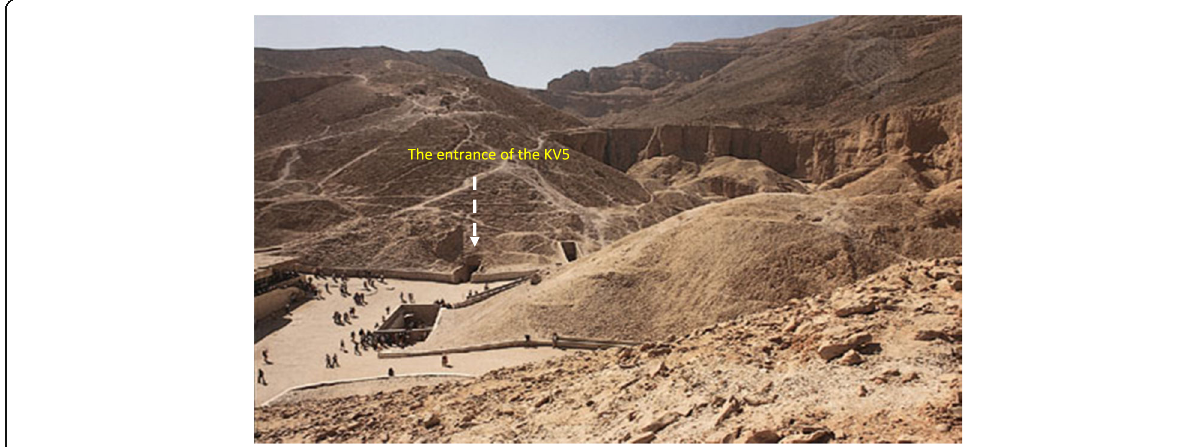
Fig. 2 Location of the tomb of Sons of Ramsses II (KV5) at the east (main) Valley of the Kings (KV), Luxor Egypt. KV 5 itself is the largest rock cut tomb in the Valley of the Kings; pillared chamber 3 is the largest chamber of any tomb in the Valley of the Kings. Chambers 1 to 6 had been discovered in 1825 by James Burton, all other had been discovered by Theban Mapping Project in 1995 (Clayton